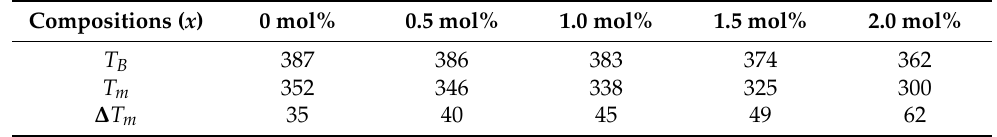
Table 2. Empirical parameters of the of NKLNTS-ST- x CuO